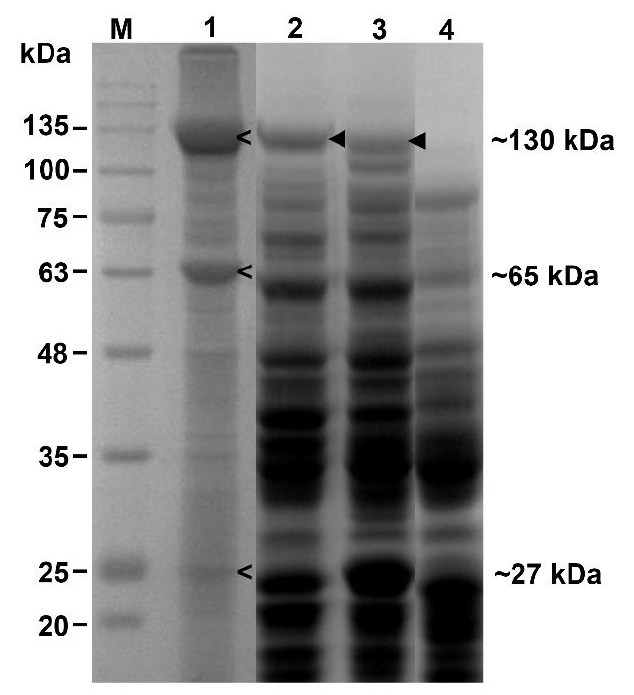
Figure 1. Expression of B. thuringiensis subsp. israelensis ( Bti ) toxins analyzed using SDS-PAGE (10% gel). Lane M: protein standard marker; lane 1: protein expression of Bti ; lane 2: protein expression of E. coli harboring cry 4Ba gene; lane 3: protein expression of E. coli harboring cry 4Aa gene; lane 4: protein expression of E. coli JM109 harboring pUC12 (negative control). Whole protein lysate was extracted from ~10 7 cells. Arrows ( < ) indicate expression of Cry toxins in Bti ; ◄ indicate heterolo- gous expression of Cry toxins in E. coli . Table 1. Mosquito larvicidal activity of B. thuringiensis subsp. israelensis and E. coli expressing dif- ferent Cry toxins against A. aegypti larvae.